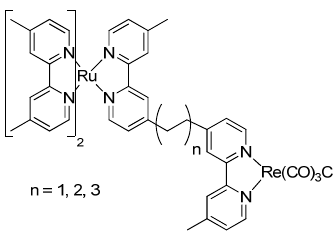
Figure 15. Covalently linked Ru-Re complexes with tethers of different lengths.